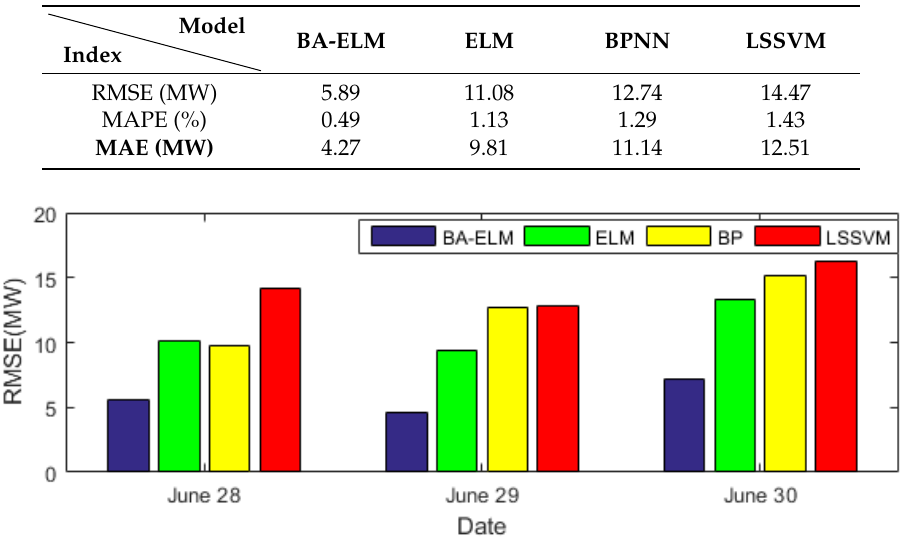
Table 11. Average forecasting results of four models.